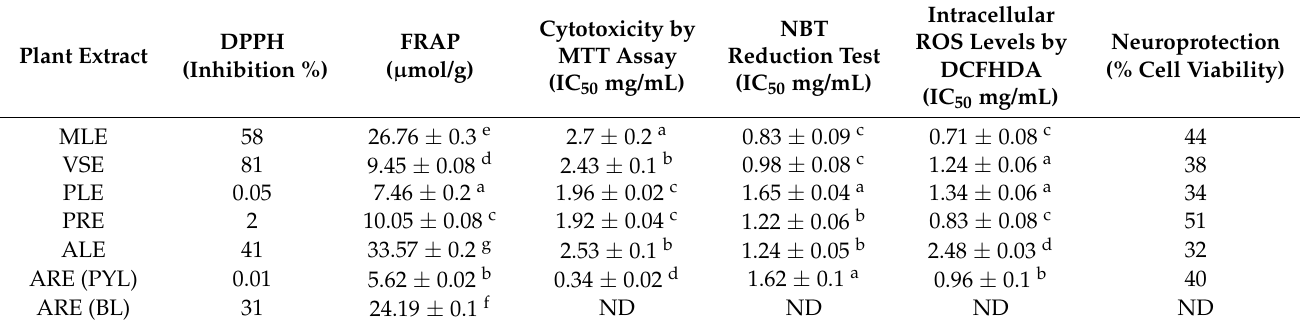
Cellular viability and antioxidant capacity and activity of selected plant extracts estimated by vari- ous tests (1,1-diphenyl-1-picryl hydrazyl (DPPH), ferric-reducing antioxidant power (FRAP), nitro-blue tetrazolium (NBT), intracellular reactive oxygen species (ROS) level by 2,7-dichlorodihydrofluorescein diacetate (DCFHDA), and neuroprotection